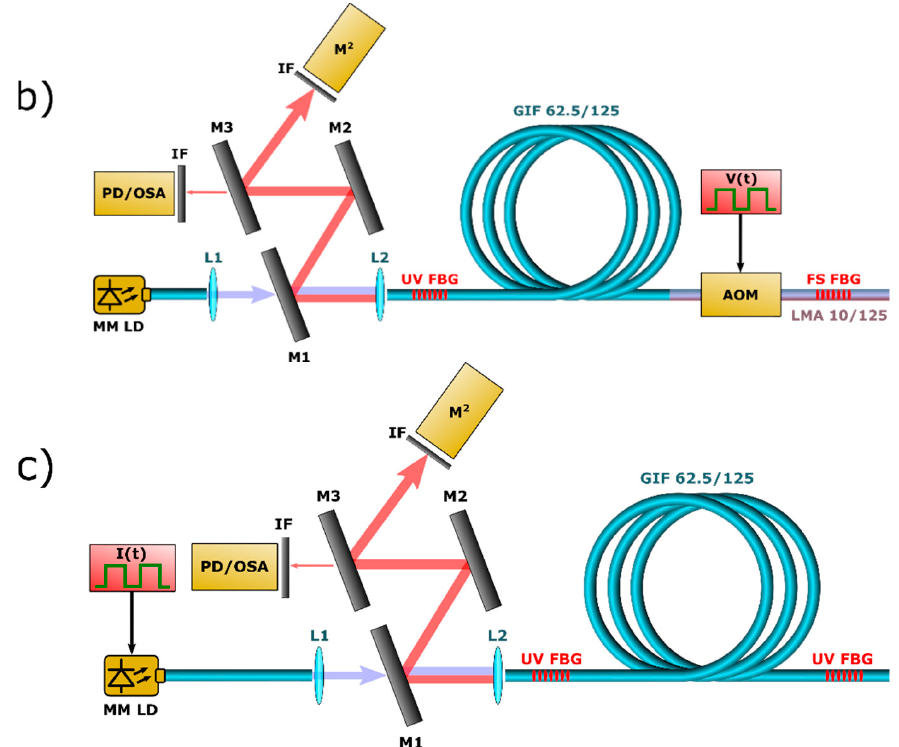
Figure 1. Experimental setup. Schemes with bulk AOM ( a ), LMA fiber-pigtailed AOM ( b ) and gain modulation ( c ): MM LD—high-power multimode laser diode at 976 nm; L1, L2, L3—collimating lenses; M1, M2, M3, M4—wavelength-selective dielectric mirrors; FBG—1018-nm fiber Bragg grating inscribed by UV or fs laser; MM GRIN fiber—multimode graded-index fiber; PD/OSA—photodetector or optical spectrum analyzer; M 2 —M 2 -meter; IF—bandpass interference filter, AOM—acousto-optic modulator.